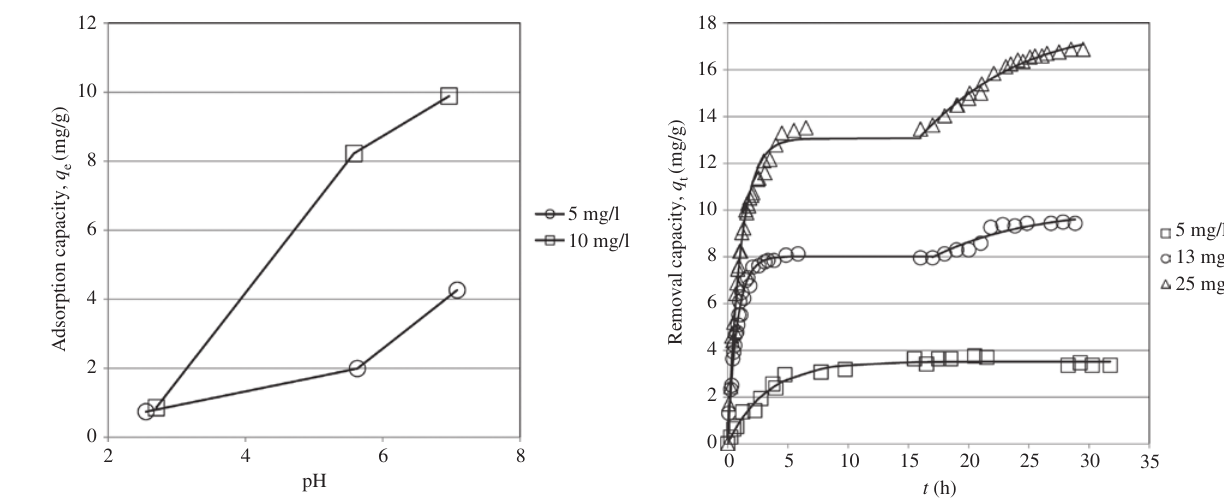
Figure 4: Effect of solution pH on the removal of methylene blue by basic-treated human hair adsorbent.